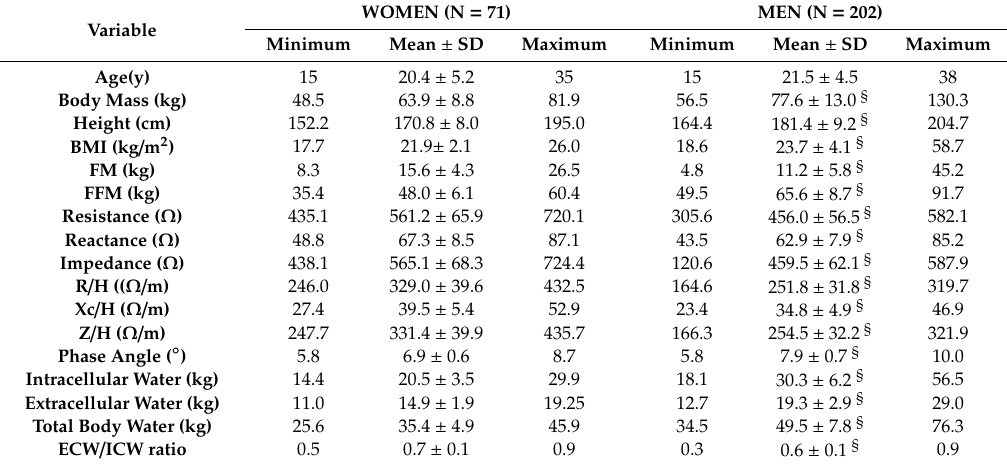
Abbreviations: BMI, body-mass index; FM, fat mass; FFM, free fat mass; E:I, extracellular:intracellular water ratio; R / H, resistance standardized for height; Xc / H, reactance standardized for height; Z / H, vector length standardized for height; SD, standard deviation. § P < 0.01 (independent sample t